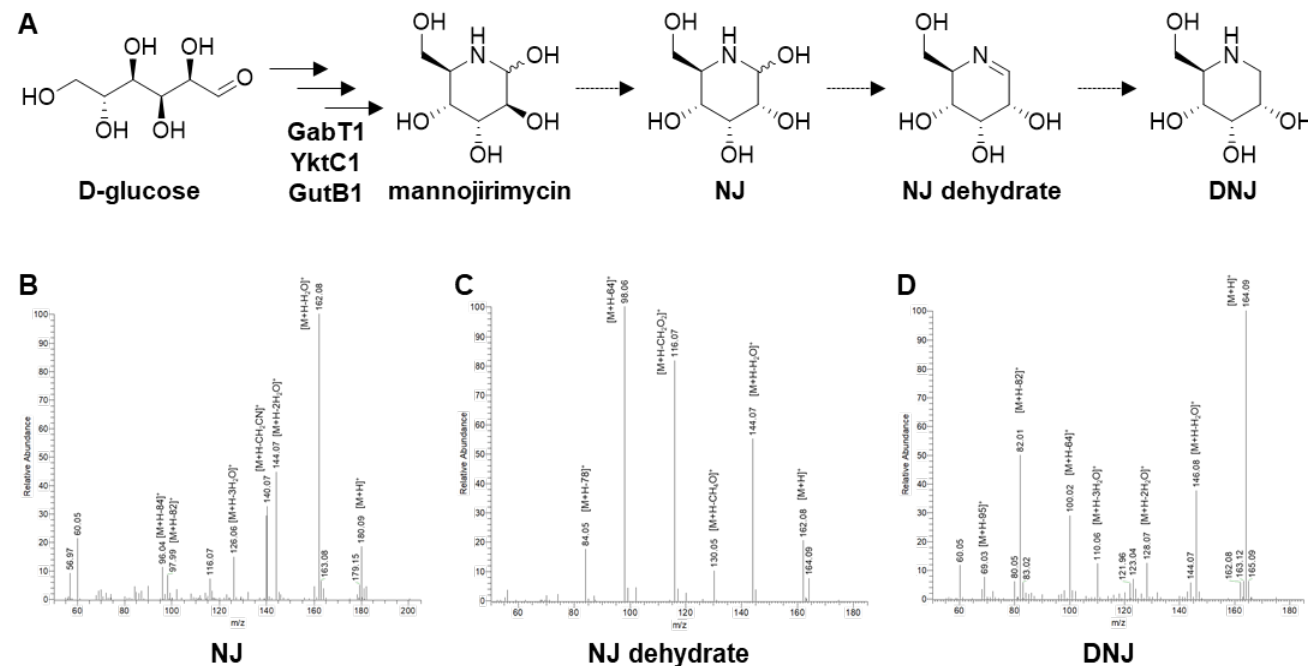
Figure 3. Biosynthetic pathways of DNJ and DNJ intermediates identified using MS/MS. DNJ biosynthetic pathway ( A ) and product ion mass spectra in positive ion mode of molecular ions corresponding to NJ ( B ), NJ dehydrate ( C ), and DNJ ( D ) from the culture extract.